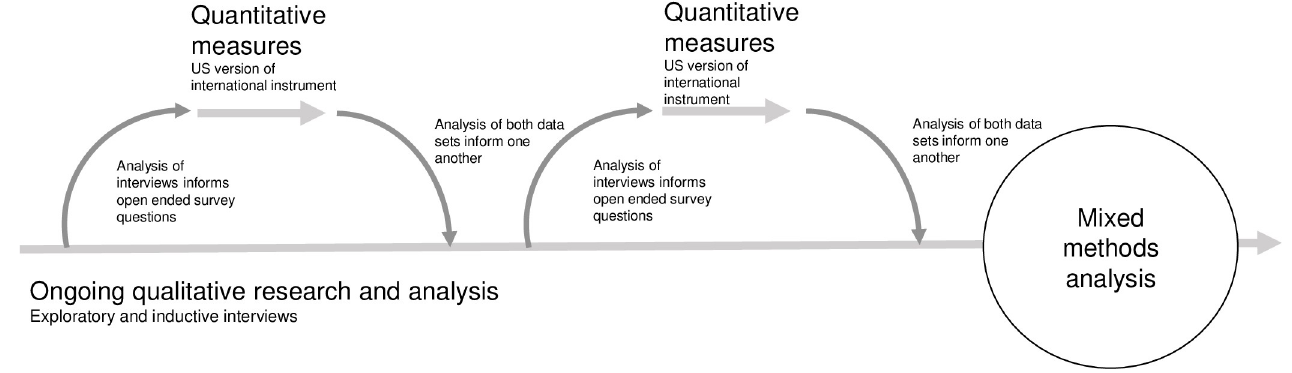
Fig 1. Mixed methods